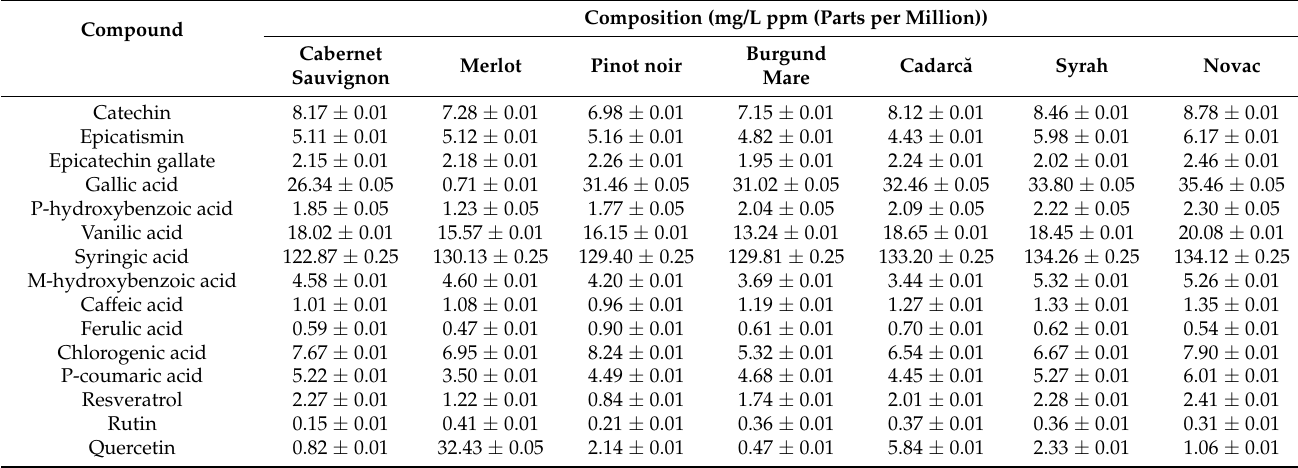
Table 1. Identification and quantification of valuable phenolic compounds in the seeds of the seven grape varieties. Compound